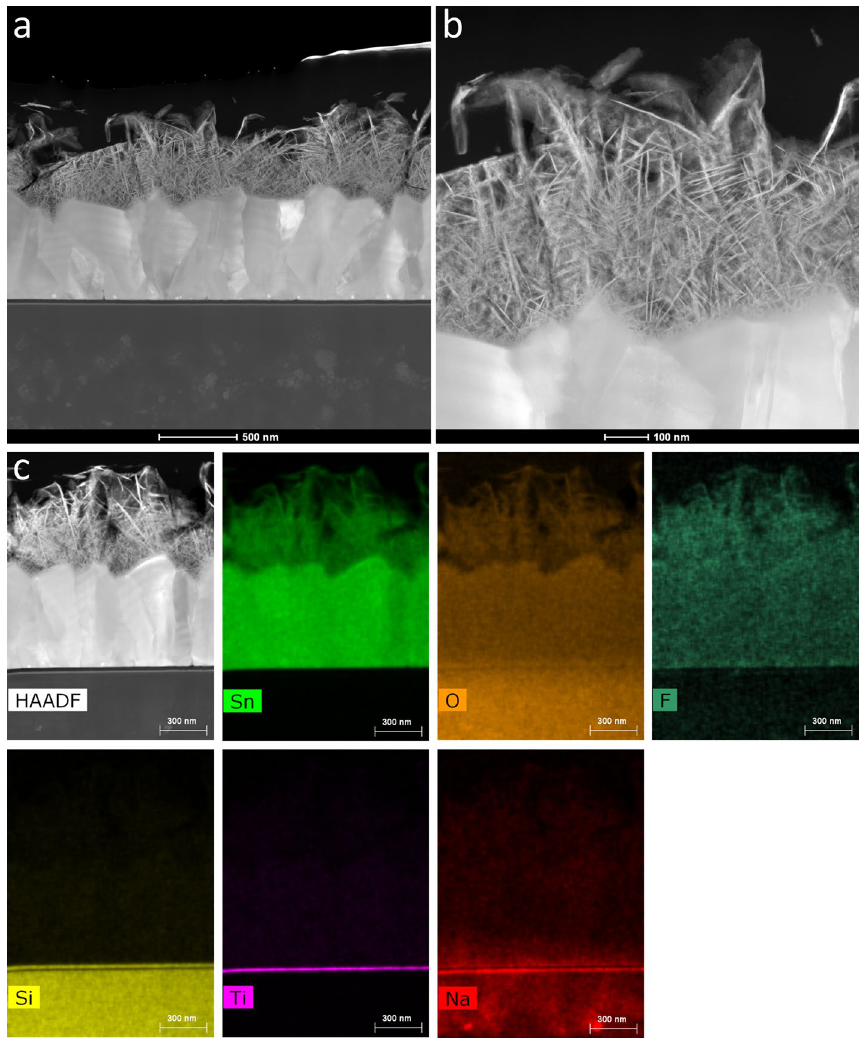
Figure 11. ( a ) Cross-sectional HAADF-STEM image of the SnO 2 (101) nanosheet assembled film on the FTO substrate. ( b ) Magnified area of ( a ). ( c ) HAADF-STEM image and its EDS mapping images for Sn, O, F, Si, Ti, and